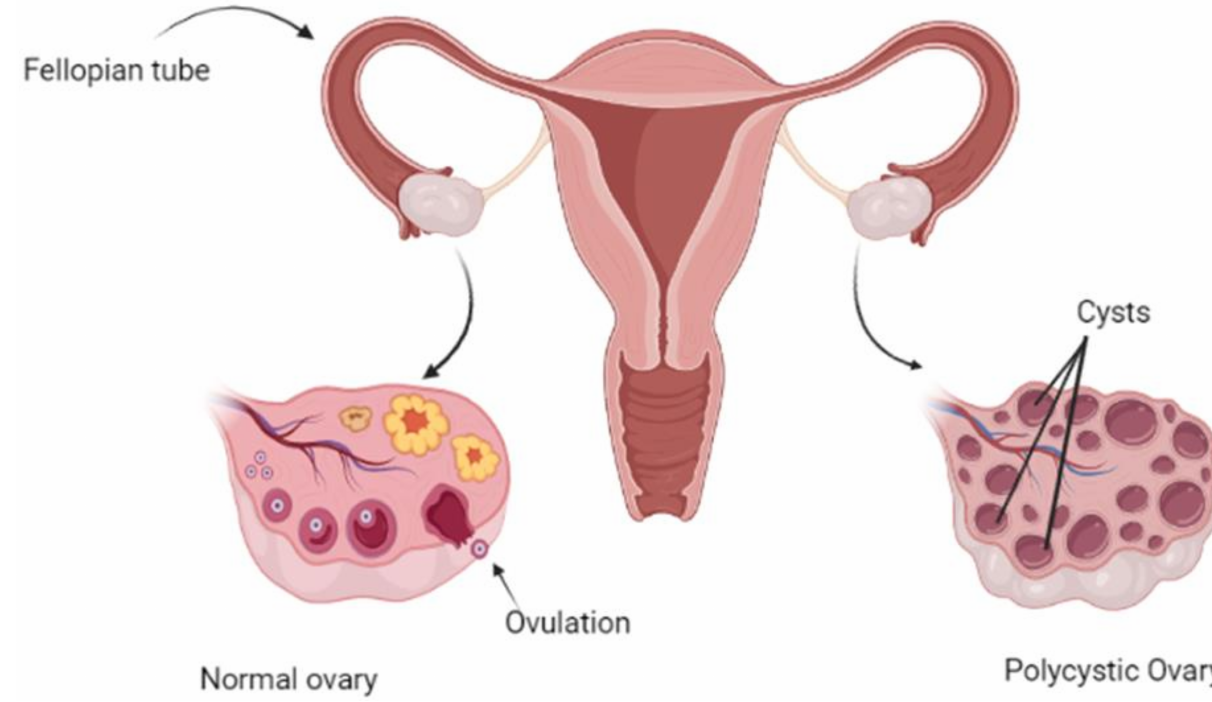
Figure 1. Diagrammatic Representation of Polycystic Ovary